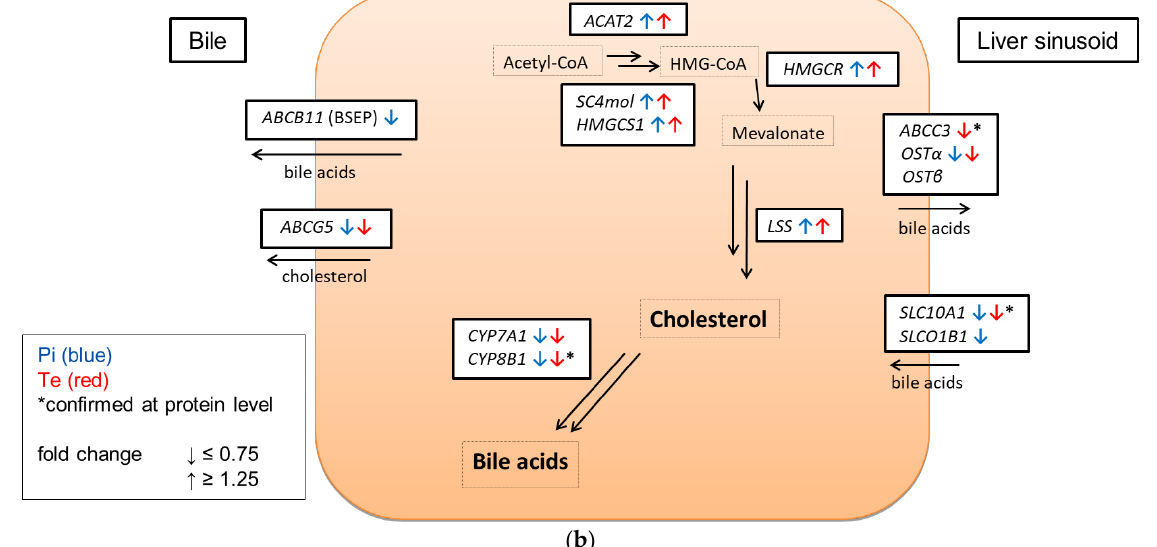
Figure 4. Cholestasis-relevant gene expression changes caused by propiconazole (Pi), tebuconazole (Te), or their combination. ( a ) CYP8B1, ABCC3 and ABCG5 expression in HepaRG cells after 24 h of treatment with Pi, Te, and their equimolar combination (Pi + Te) from 2.5 μ M to 40 μ M. Statistical significance was reached at p < 0.05 and is indicated by asterisks (Mann–Whitney rank sum test against the solvent control). ( b ) Overview of effects of Pi (blue) and Te (red) on the expression of cholestasis-related genes. HepaRG cells were treated with Pi or Te for 24 h. Upward and downward arrows indicate up- or down-regulation if (i) statistical significance was reached at p < 0.05 (testing as described in the methods section), and (ii) fold change of expression was ≥1.25 or ≤0.75. * indicates that the respective gene was also altered at the protein level. Abbreviations: ABC: ATP binding cassette; CYP: cytochrome P450; SLC: solute carrier.